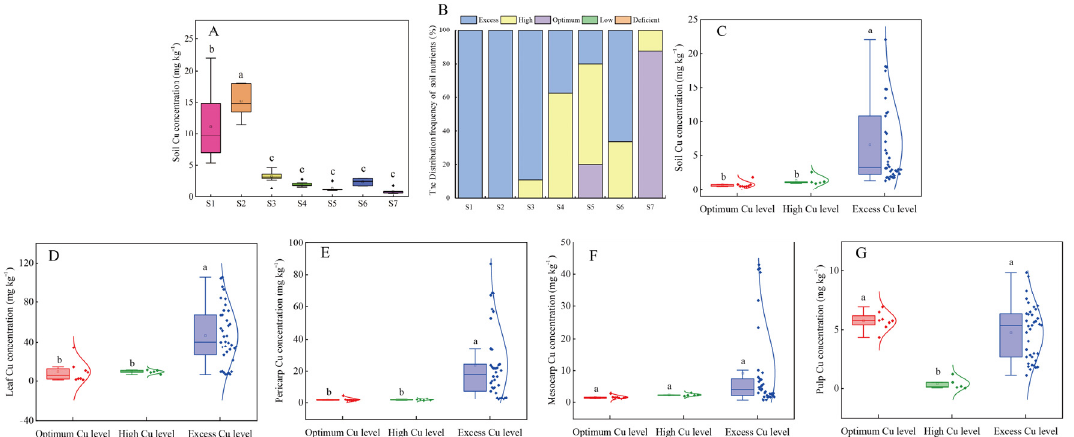
Figure 1. The Cu concentrations of soil, leaf, and fruit. ( A ) Soil available Cu concentrations in different orchards; ( B ) the classification of soil available Cu in different orchards; the Cu concentrations of soil available Cu ( C ), leaf Cu ( D ); pericarp Cu ( E ); mesocarp Cu ( F ); pulp Cu ( G ) under different soil Cu levels. The different letters above the box plots indicate significant differences between different soil Cu levels at 5% level ( p < 0.05; n s1 = 10, n s2 = 5, n s3 = 9, n s4 = 8, n s5 = 5, n s6 = 6, n s7 = 8; n opimum Cu level = 8, n high Cu level = 5, n excess Cu level = 38).